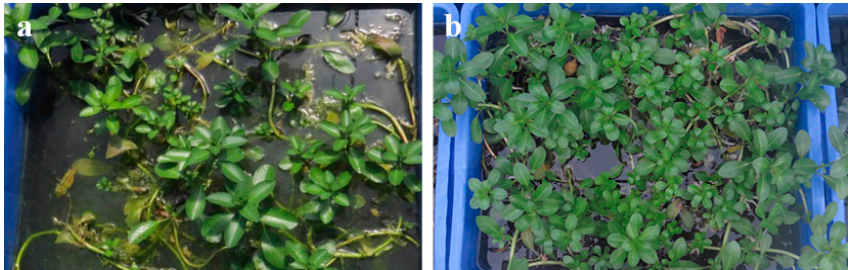
Figure 2. Growth status of Ludwigia adscendens in swine manure wastewater: ( a ) day 0 and ( b ) day 15.